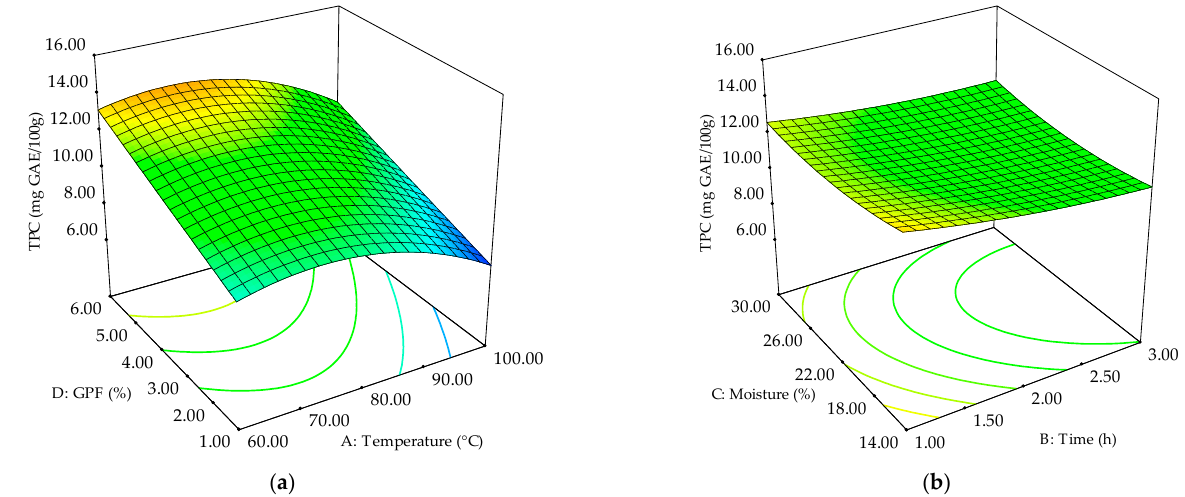
Figure 6. Three-dimensional response surface plots presenting the synergistic effects of factors: GPF level–temperature ( a ) and moisture-time ( b ) on total polyphenolics content (TPC).